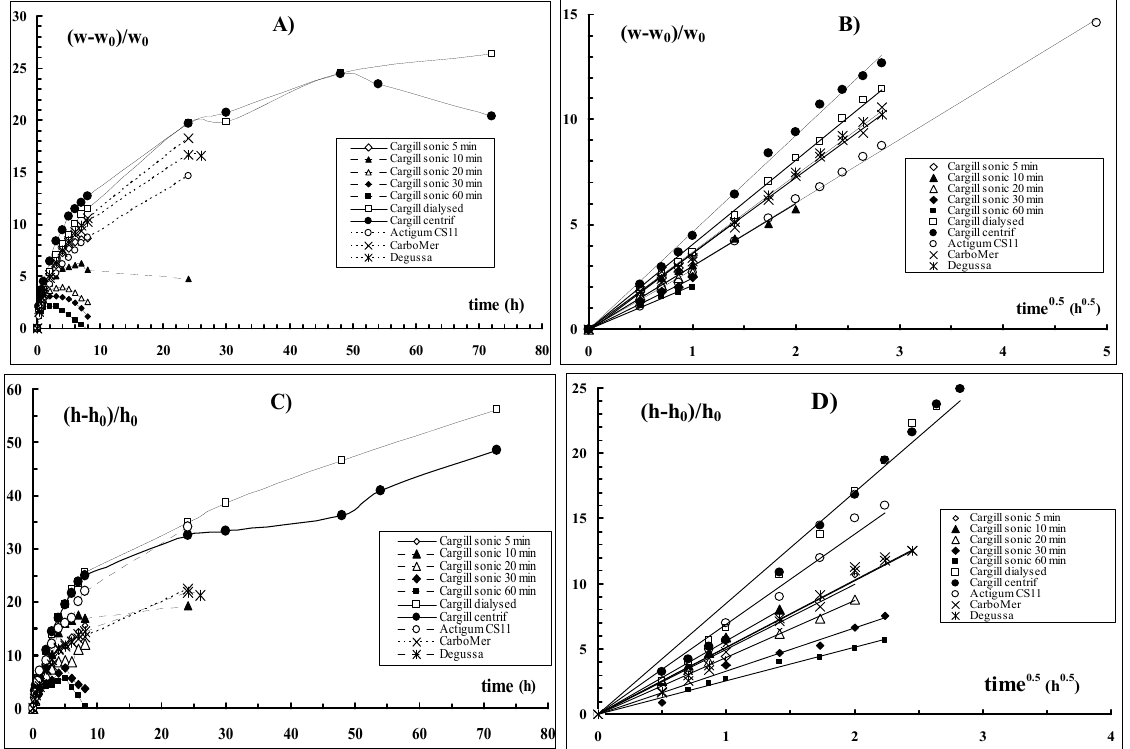
)/w ; (A) and relative height increase ((h-h Figure 8. Water uptake ((w-w 0 0 tablets of Sclg/borax prepared with Sclg of different brands (Cargill dialysed, Cargill centrifuged, Actigum CS11, CarboMer and Degussa) and with Sclg sonicated for different periods of time (Cargill sonicated for 5, 10, 20, 30 and 60 min). (A) and (C): as a function of time; (B) and (D): as a function of the square root of time. Experiments were carried out in triplicate and the obtained values always laid within 10% of the